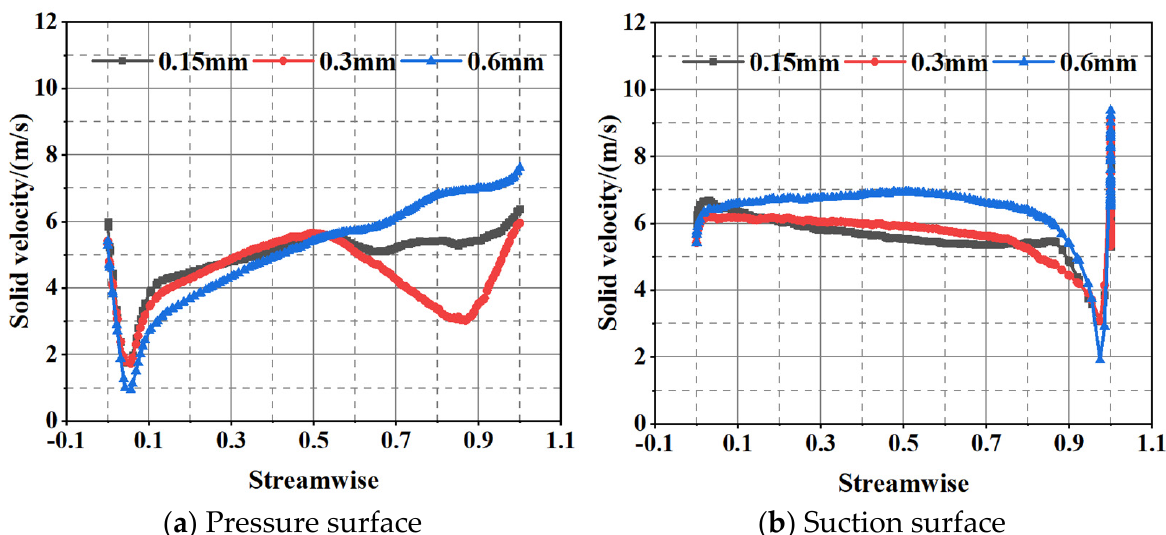
Figure 13. ( a , b ) Solid velocity distribution of the blade. Figure 14 shows the solid volume fraction distribution of the impeller when the particle volume concentration was 15% and the particle diameters were 0.15, 0.3, and 0.6 mm. It was found that with the increase in solid particle diameter, the region of